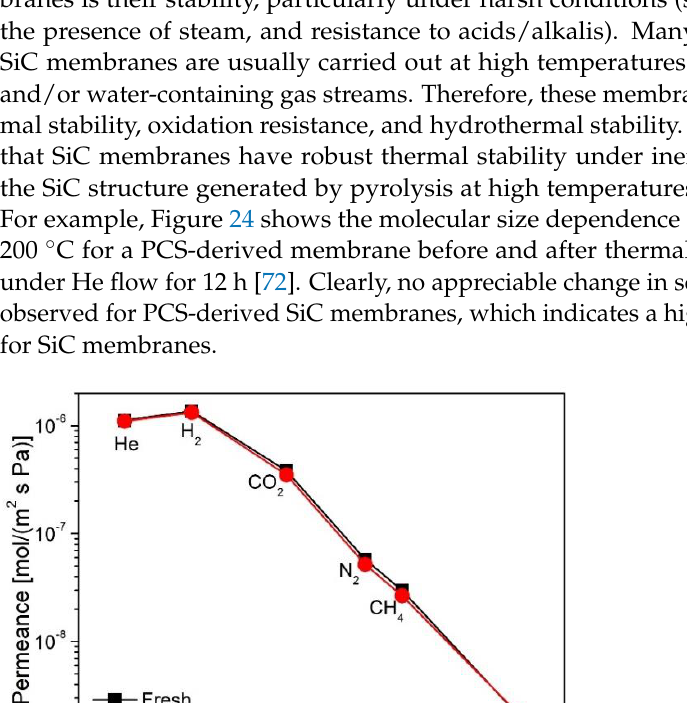
Figure 23. Comparison of the selectivities for ( a ) H 2 /N 2 and ( b ) N 2 /SF 6 by various membranes